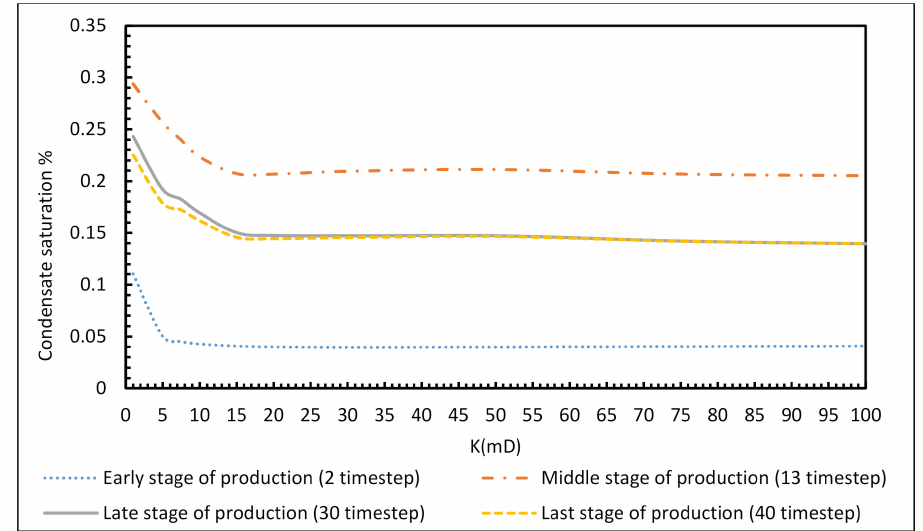
Figure 10. Condensate saturation as a function of permeability for di ff erent stages of production at the wellbore (local